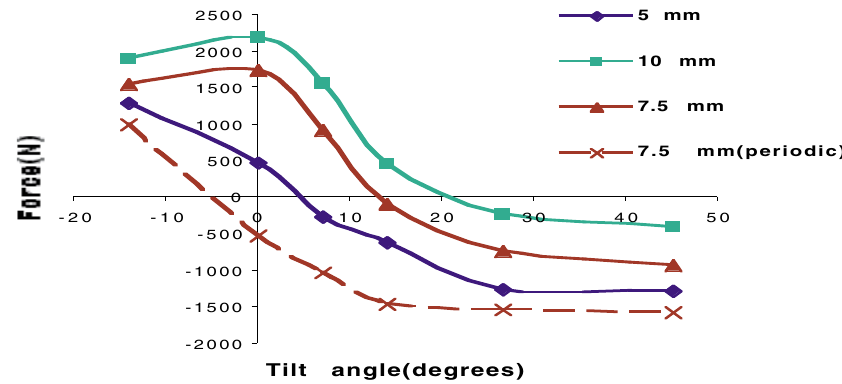
FIG. 6. (Color) Forces on the beam as a function of the tilt angle for different displacement